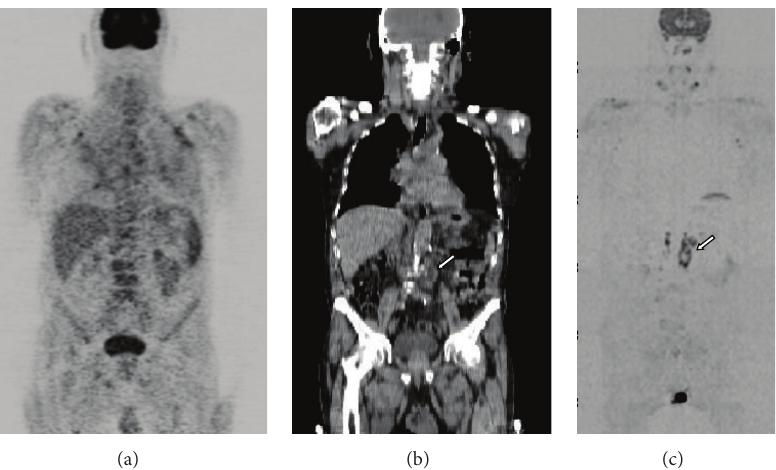
Figure 2: An 82-year-old man with gastric MALT lymphoma: (a) MIP image of 18 F-FDG-PET showing no uptake in any lymph node regions, giving stage 0; (b) coronal whole-body CT, showing multiple para-aortic lymph nodes, thus giving stage II (arrow); (c) MIP image of DWI showing the same findings, as high signal intensity in the same nodal location, giving stage II (arrow). However, all techniques, even DWI, failed to find the primary gastric